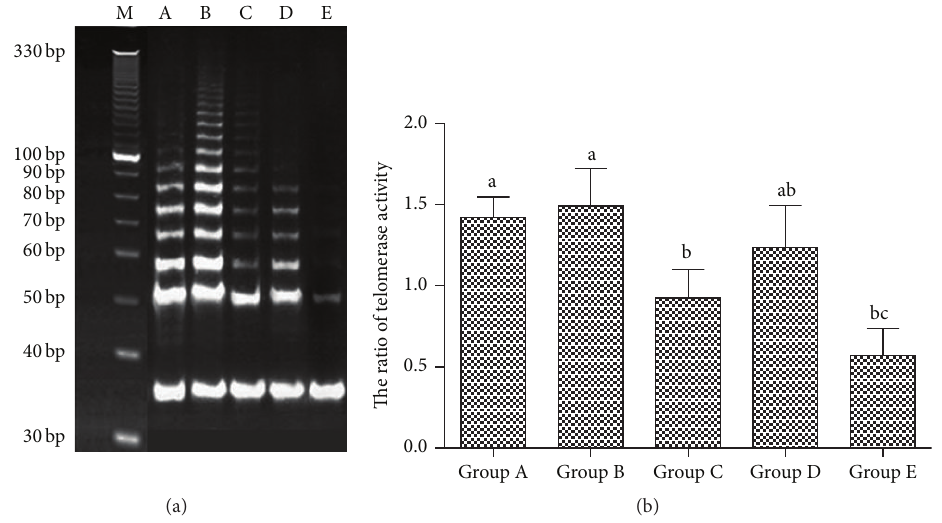
Figure 8: Telomerase activity in the Sca-1 + HSPCs. (a) Result of TRAP-PCR. (b) Telomerase activity. M: DNA mark, A: Group A (3-4-week- old mice, 13–16g in body weight), B: Group B (8-9-week-old mice, 20–25 g in body weight), C: Group C (6-month-old mice, 35–40 g in body weight), D: Group D (12-month-old mice, 39–43 g in body weight), and E: Group E (18-month-old mice, 37–45 g in body weight). (a–c) represent a significant difference of these columns ( 𝑃 < 0.01 ).